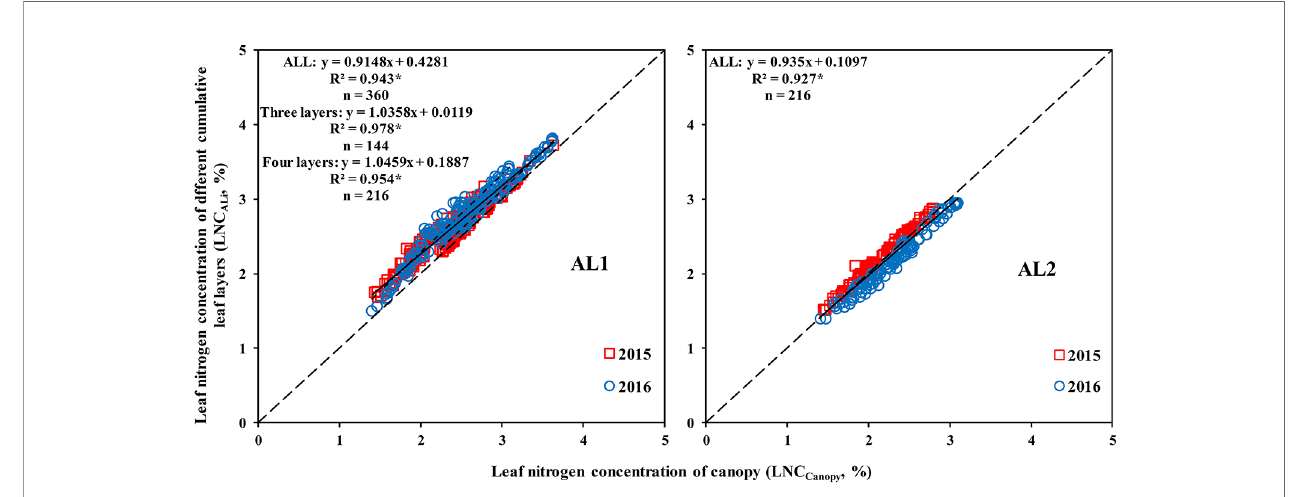
FIGURE 6 | Relationship between the LNC ALi and LNC Canopy . * means accurate to